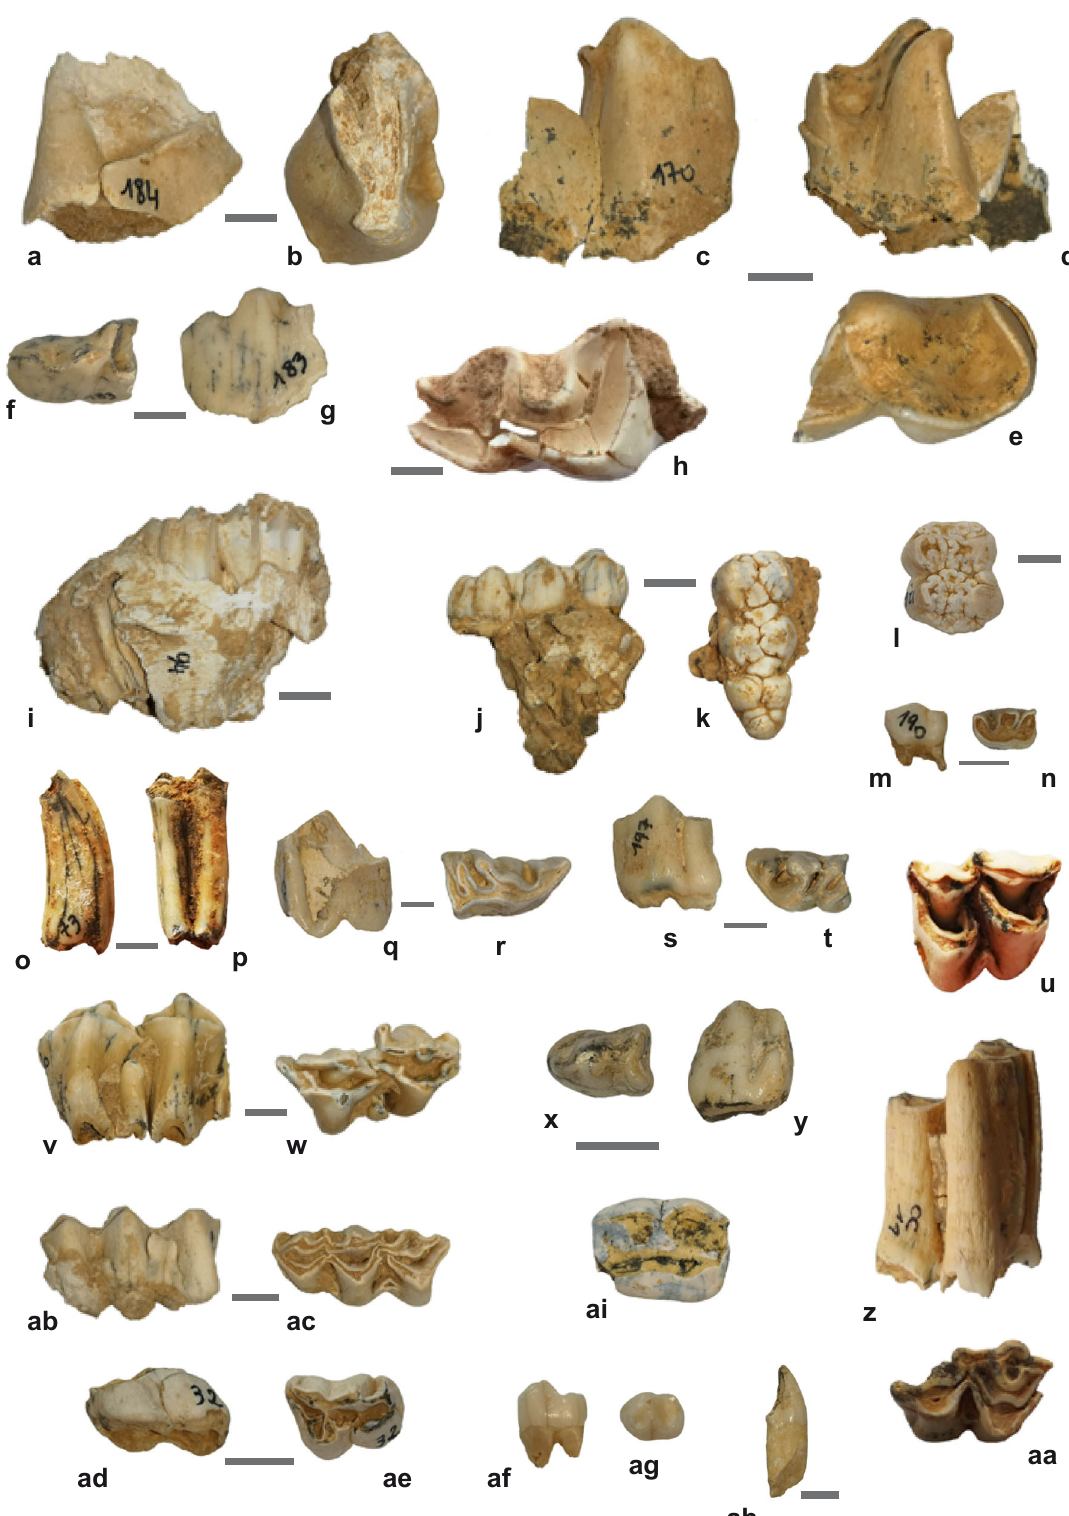
Associated fauna from Tam Ngu Hao 2 cave Description . Thirty-eight identi fi ed teeth (one deciduous and 37 permanent) of suids and numerous small fragments display the morphological pattern of Sus with bunodont cusps and cuspids on molars and numerous accessory tubercles. Only 12 teeth (most premolars) out of 38 are complete, with the majority being